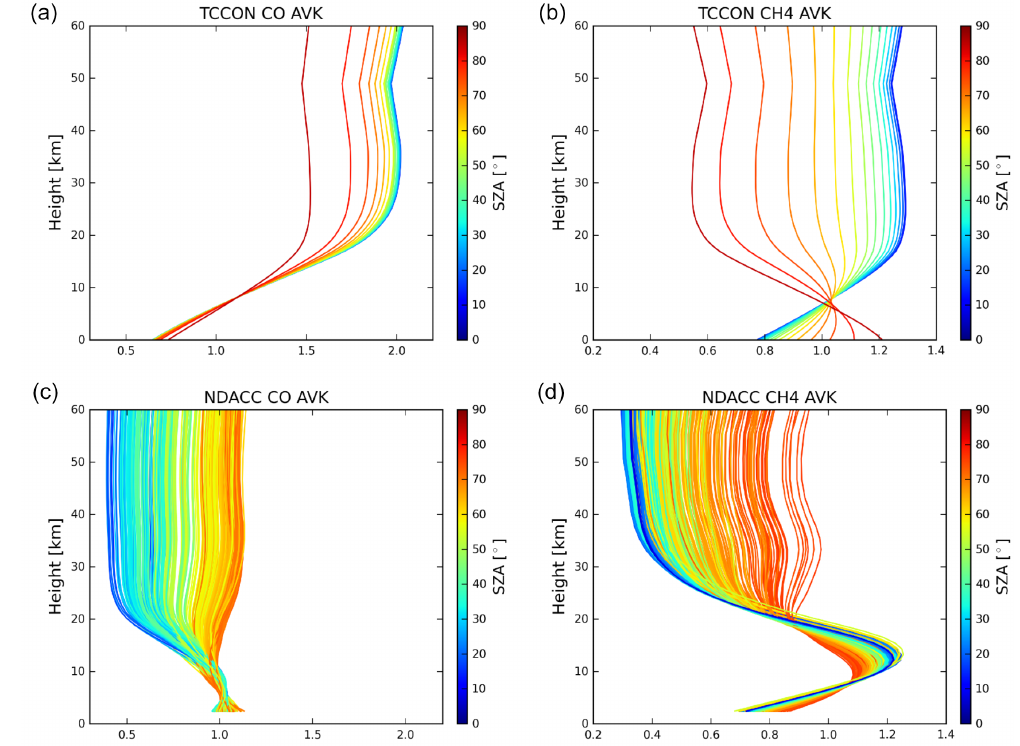
Figure 2. The top panels are the column averaging kernels of TCCON CO (a) and CH 4 (b) retrievals; the lower panels are the column averaging kernels of NDACC CO (c) and CH 4 (d) retrievals. All averaging kernels vary with the solar zenith angle (SZA). Note that the ranges of the x axes for CO and CH 4 are